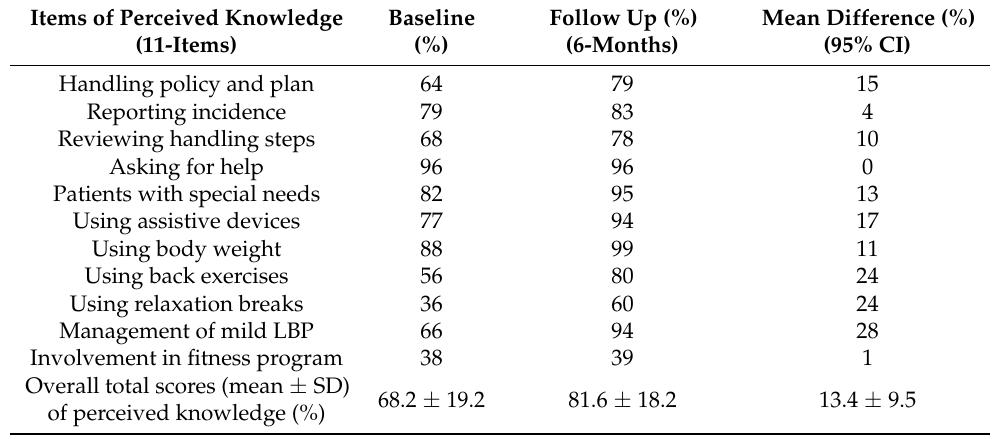
Table 2. Item-wise differences in baseline vs. follow-up data of perceived knowledge.